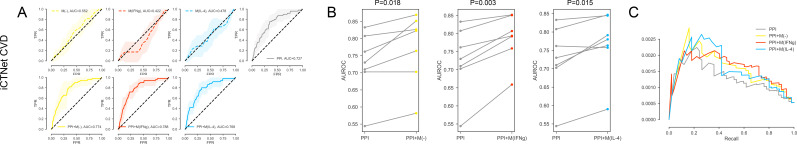
For the iCTNet CVD drug targets.(A) The k-fold cross-validated (k = 7) ROC curves for M(-), M(IFNγ), M(IL-4), PPI, PPI + M(-), PPI + M(IFNγ) and PPI + M(IL-4), respectively. Shaded regions represent the standard deviation of the AUROC values from all folds. (B) The AUROC values of each individual fold from the cross-validation for PPI and PPI + M(-), PPI and PPI + M(IFNγ), PPI and PPI + M(IL-4), respectively. Paired t-test was performed to obtain two-sided p-values. (C) Precision-recall curves for PPI, PPI + M(-), PPI + M(IFNγ) and PPI + M(IL-4).